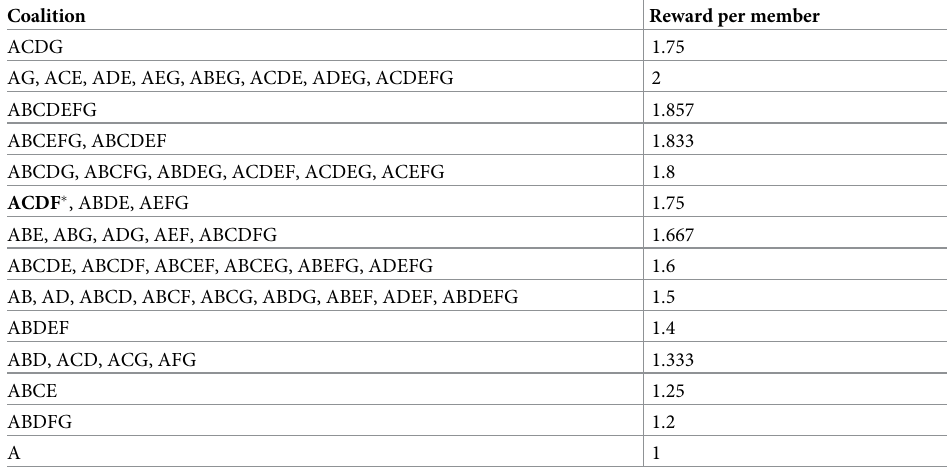
Table 2. Coalition preferences of the human player (A) in the game with a single core partition.